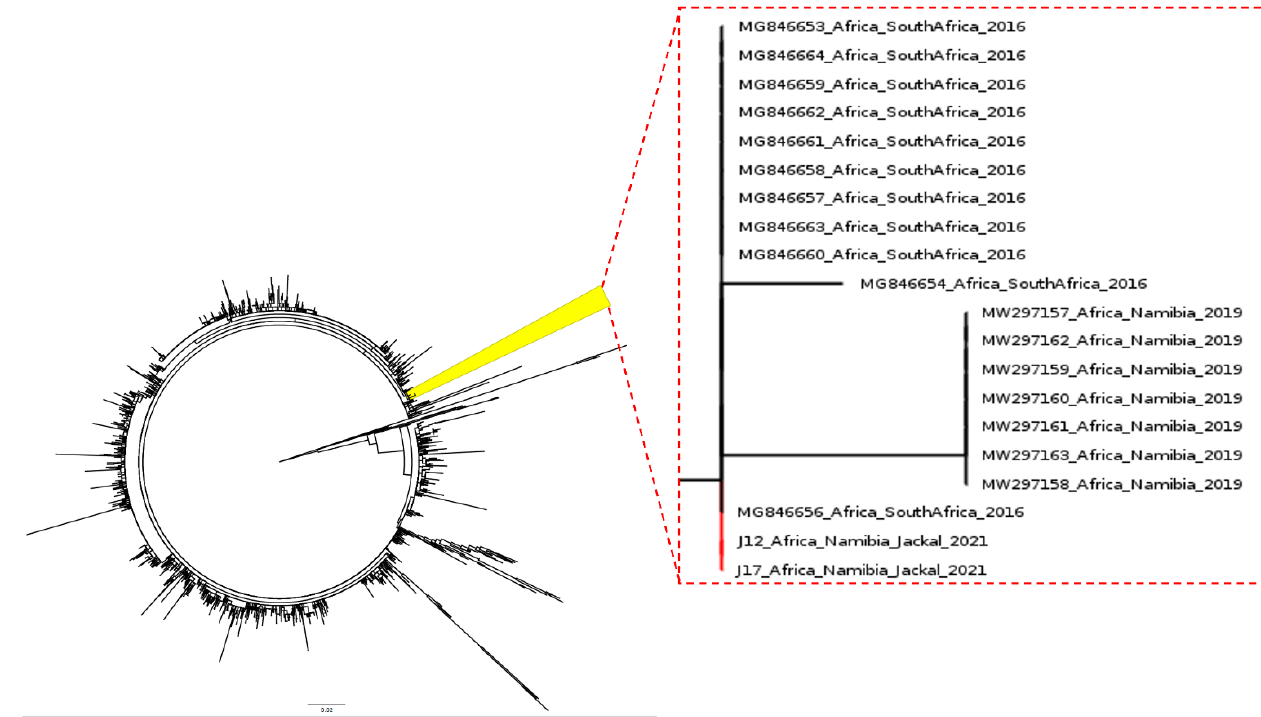
Figure 2. Maximum-likelihood phylogenetic tree based on a broad collection of complete ORF2 gene sequences of PCV-2b strains collected globally. The tree subset including the strains obtained in the present study (represented by branches) has been magnified (right insert).